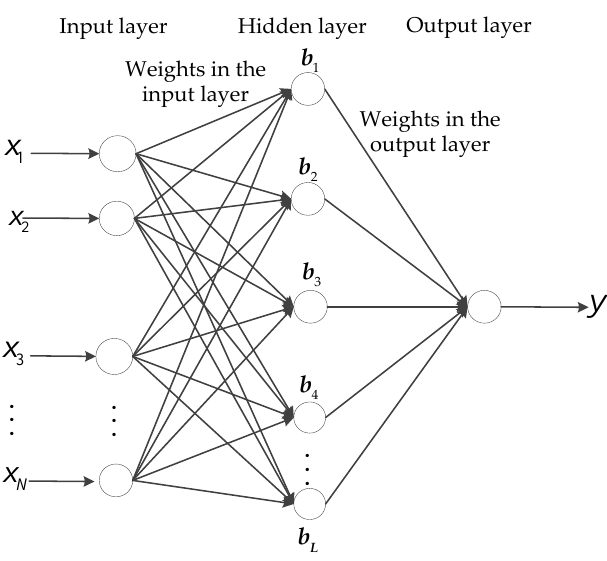
Figure 2. Structure of the extreme learning machine (ELM).